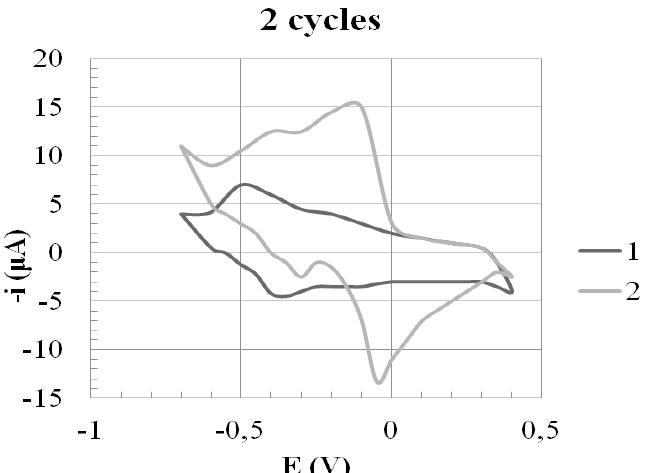
Figure 9. Cyclic voltammograms of (1) 1 mol L -1 NH OH + 1 mol L -1 NH 4 Cu 2+ + 1 mol L -1 NH OH + 1 mol L -1 NH NO at PoAP film-coated GCE (Scan rate = 50 mV s -1 ) PoAP obtained film after 2nd polymerization 4 4 3